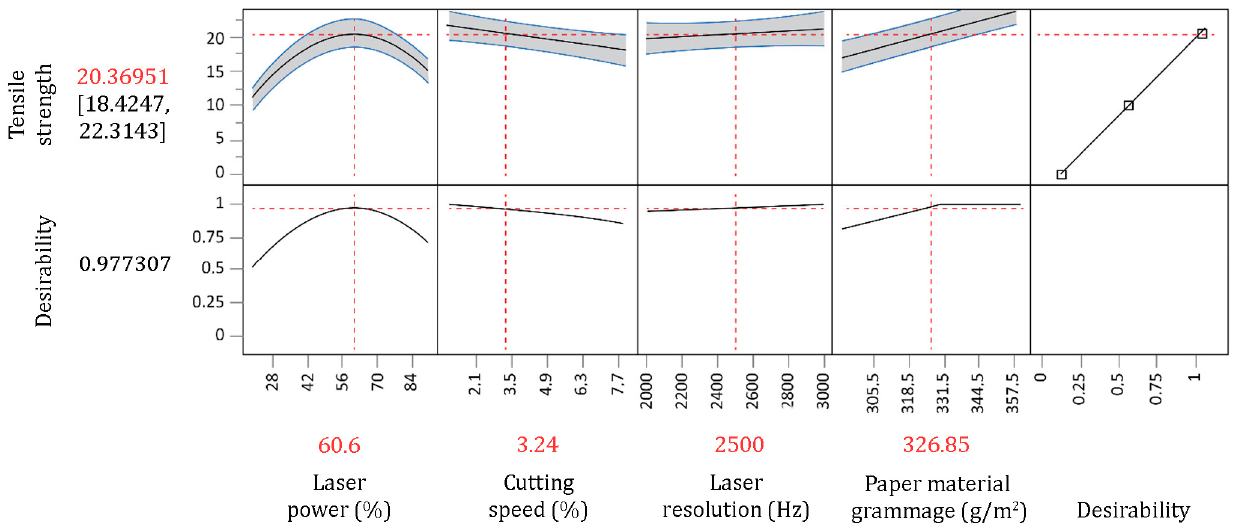
Figure 7. Optimization diagram.